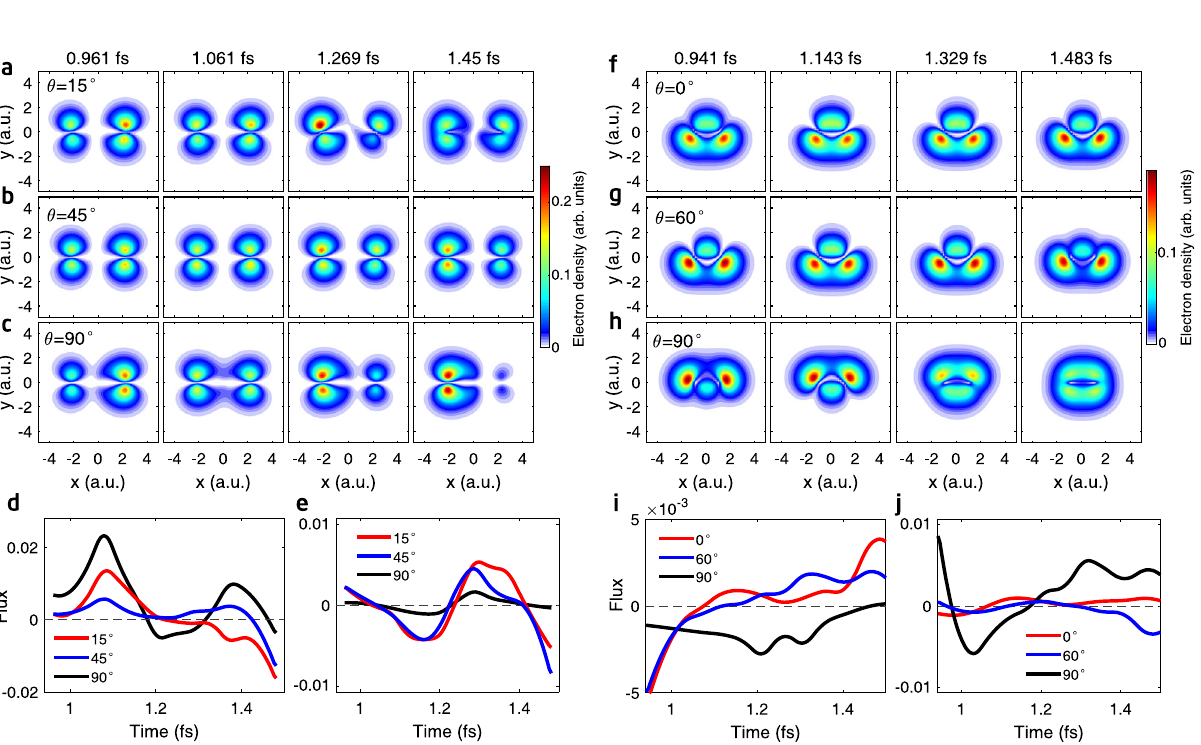
Fig. 4 | Alignment-angle-dependent attosecond charge migration in N + 2 and CO + 2 . a – c Snapshots of the reconstructed hole densities in CO + 2 for the alignment angles of 15°, 45° and 90°, respectively. d Flux of charge density crossing the x = 0 plane for the three angles in ( a – c) . e Same as ( d ), but for the y = 0 plane. Positive